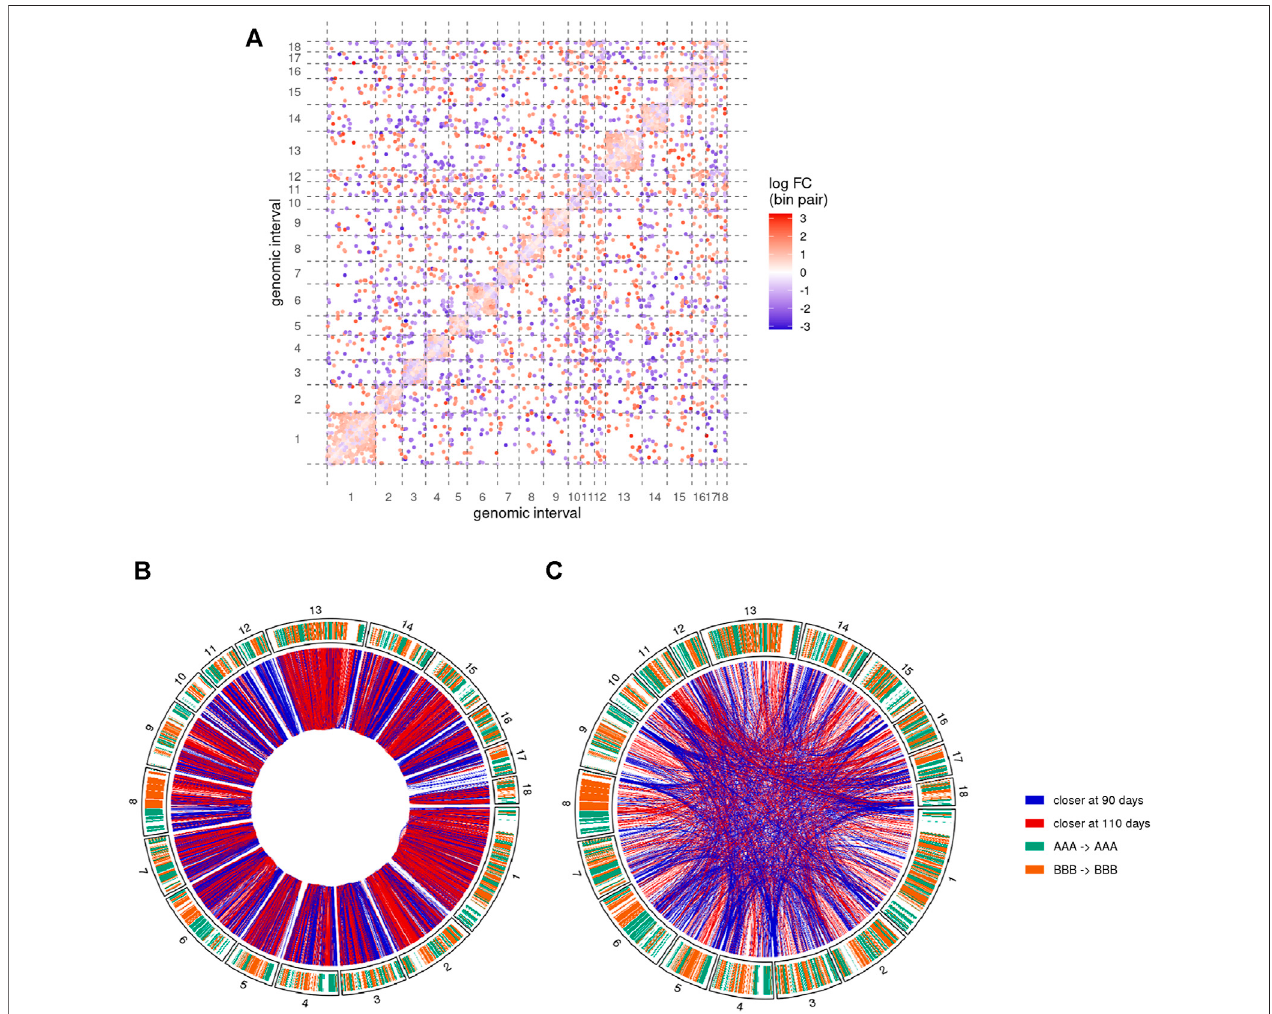
FIGURE5| Pairsofgenomicregionswithdifferentialinteractionsbetween90and110 daysofgestation.ResultsofthecomparativeanalysisoftheHi-Cmatricesat 500 Kbresolutionshow differential interactions alongthe 18assembledautosomes (A) Differentialinteraction matrix. Each dotrepresentsapairofgenomicinterval with a signi fi cantly different interaction value and its associated log-fold change value (logFC, blue-white-red gradient scale). Positive values of logFC correspond to genomic regions closer at 110 days of gestation than at 90 days (red dots). Inversely, negative values indicate regions that were closer at 90 days (blue dots). Same colors are used to display cis (B) and trans (C) differential interactions as red (positive logFC) or blue (negative logFC) connections between genomic regions (outer circle). Chromosome inner color shows the genomic segmentation into A (turquoise) and B (orange) stable compartments. See also Supplementary Figures S3 and S4 .